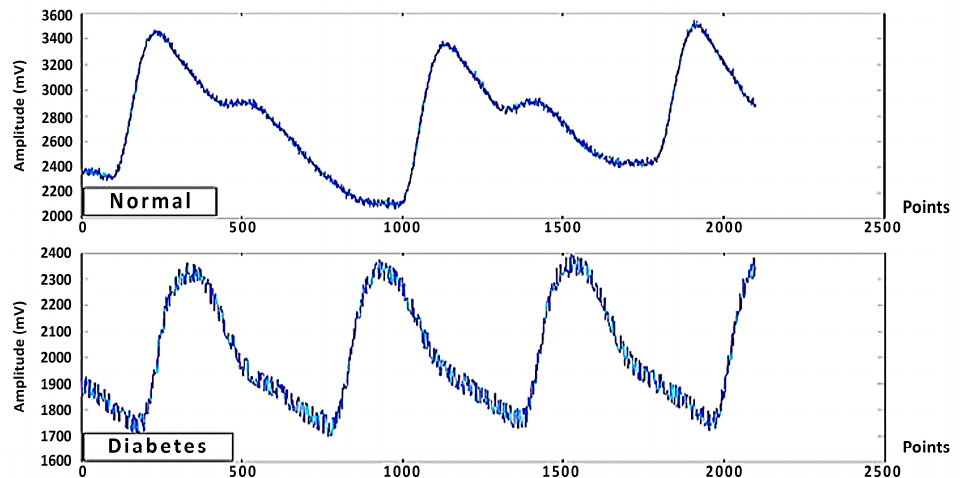
Figure 3. The PPG signal structure tends to differ between individuals with diabetes and healthy subjects.